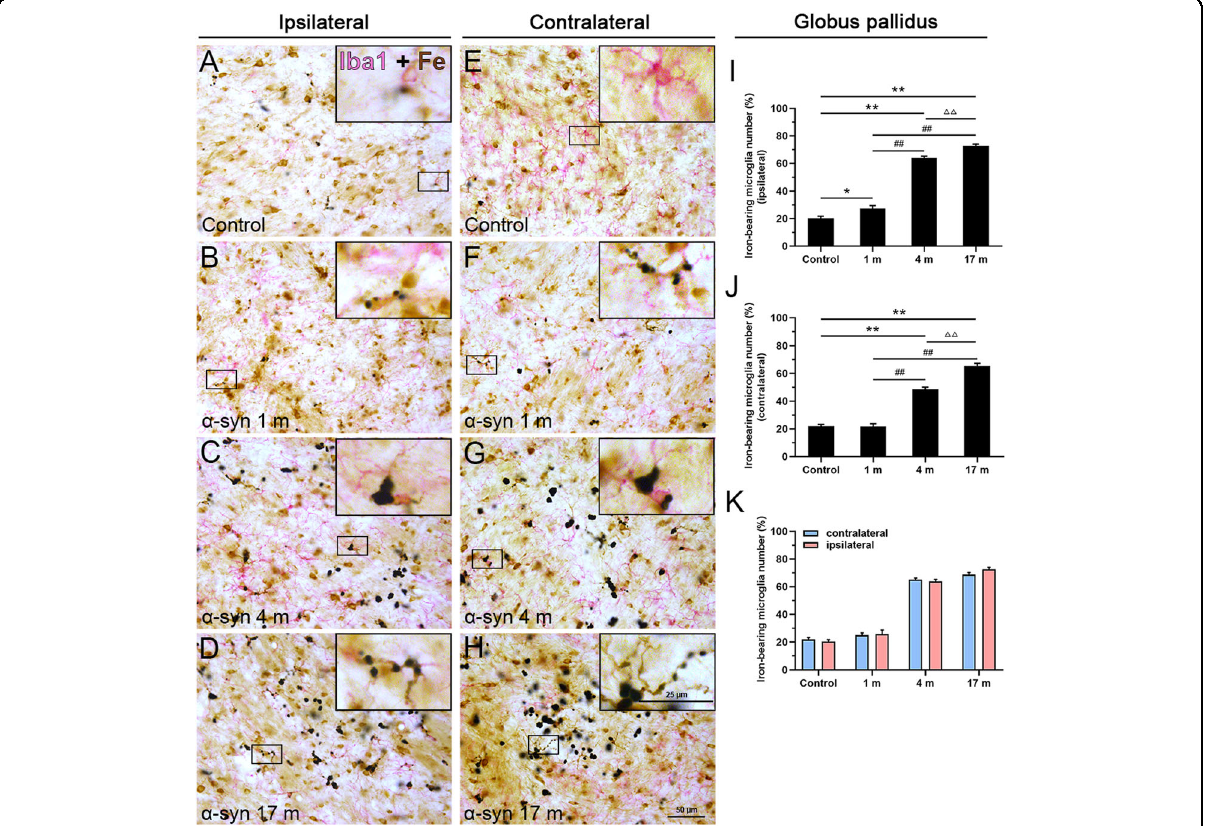
Fig. 6 Cellular localization of iron deposits in microglia in the globus pallidus. Double-labeling of chemically stained iron ions (dark brown) along with immunohistochemical staining using an Iba1 antibody (magenta) shows overlapping of iron deposition in Iba1-positive microglia in the control ( A ) and 1, 4, and 17 months after the treatments with α -syn PFFs in the ipsilateral side ( B – D ), control group ( E ) and 1, 4, and 17 months after treatment with α -syn PFFs in the contralateral side ( F – H ). I – K Quantitative analyses of iron deposition in microglia in the substantia nigra (ipsilateral side: I ; contralateral side: J ; both sides: K ). α -Syn, α -synuclein. The data are presented as the mean ± SEM of three independent experiments. * p < 0.05 and ** p < 0.01 vs. control group, ## p < 0.01 vs. 1-month group, ΔΔ p < 0.01 vs. 4-month group, one-way ANOVA ( I , J ). Scale bars: 50 μ m in A – H and 25 µm in the